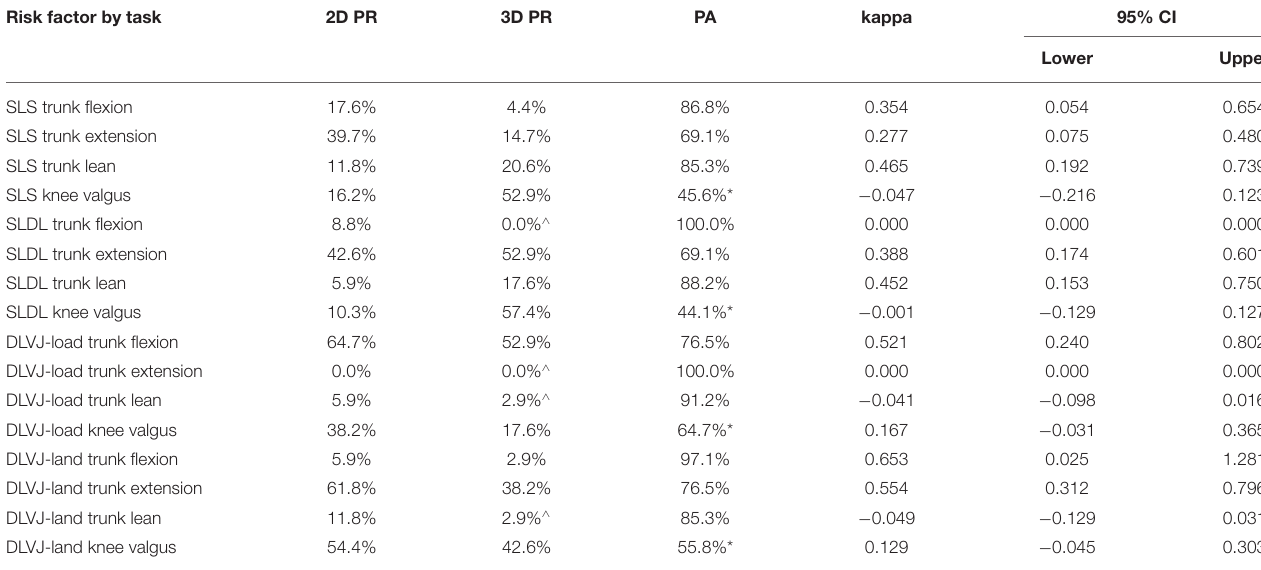
TABLE 3 | Percent risk (PR) and percent agreement (PA) for each risk factor by task. Risk factor by task 2D PR 3D PR PA